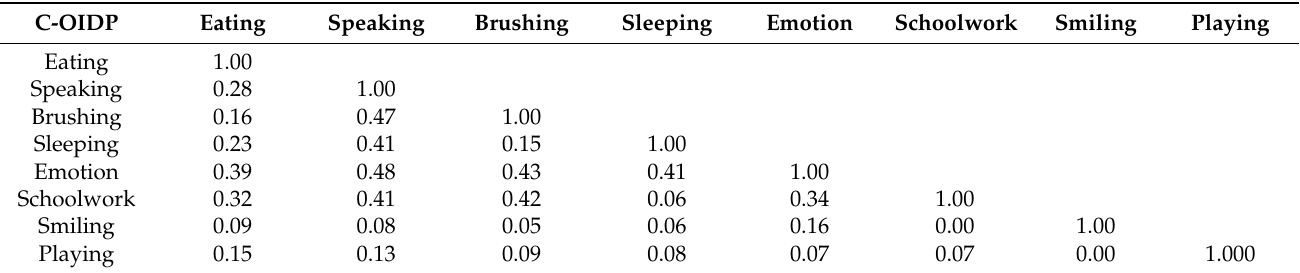
Table 2. Reliability analysis: Inter-item correlation for the C-OIDP.